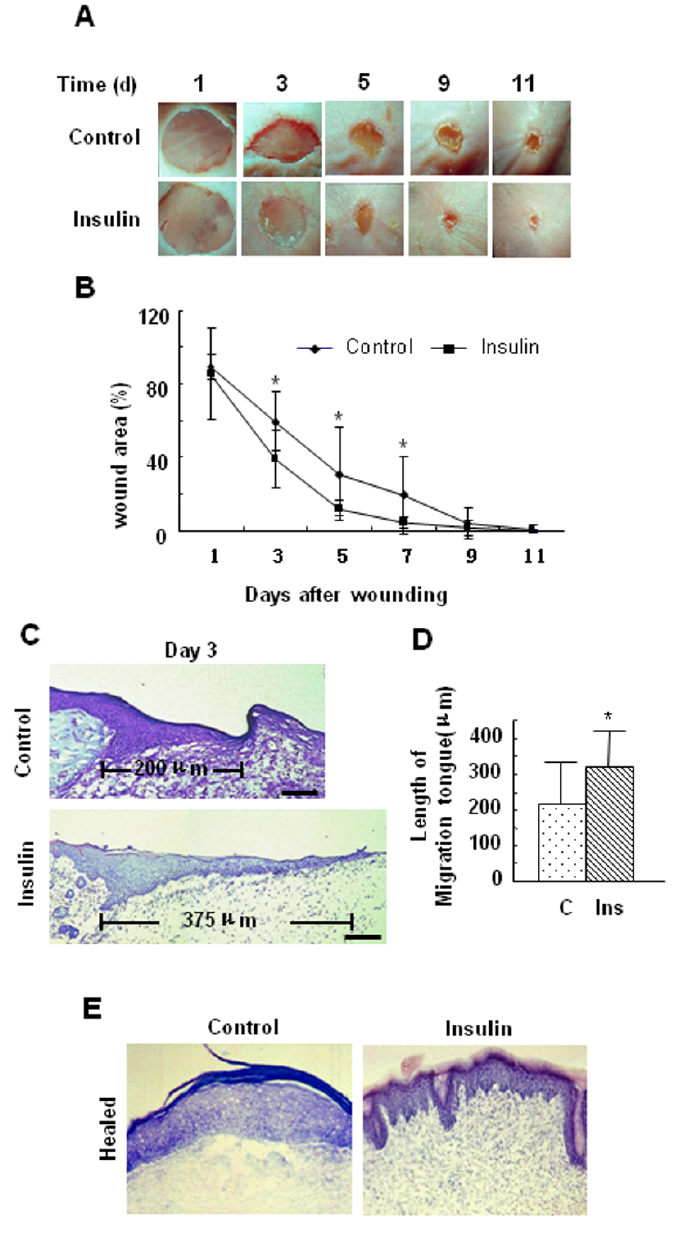
Figure 1 Insulin accelerates wound healing and improves the quality of re-epithelialization . Excision wounds were per- formed in C57BL/6J mice, and the healing process was monitored at different time points. (A) Representative images of wounds which were treated with vehicle (30 μ l saline solution) or 0.03 u insulin/30 μ l saline solution every two days. (B) Wound area was quantified every two days and expressed as the percentage of the original wound area (n = 9; Statistics are shown as comparisons between the treatment and control. *P < 0.05). Insulin significantly decreased wound area. (C, D) The length of the migrating tongues was determined by measuring the distance from the margin of the wound to the tip of the migrating keratinocytes at 40× magnification, in which one unit equals 25 μ m. (C) Representative hematoxylin and eosin- stained sections showing longer migrating tongue in insulin treated wounds. Scale bars indicate 50 μ m. (D) Data are shown as the mean value +/- SD. Statistics are shown as comparisons between the treatment and control (n = 9). *P < 0.05. (E) Repre- sentative hematoxylin and eosin-stained sections showing increased number of epidermal reticular ridges and dermal papilla in insulin treated healed